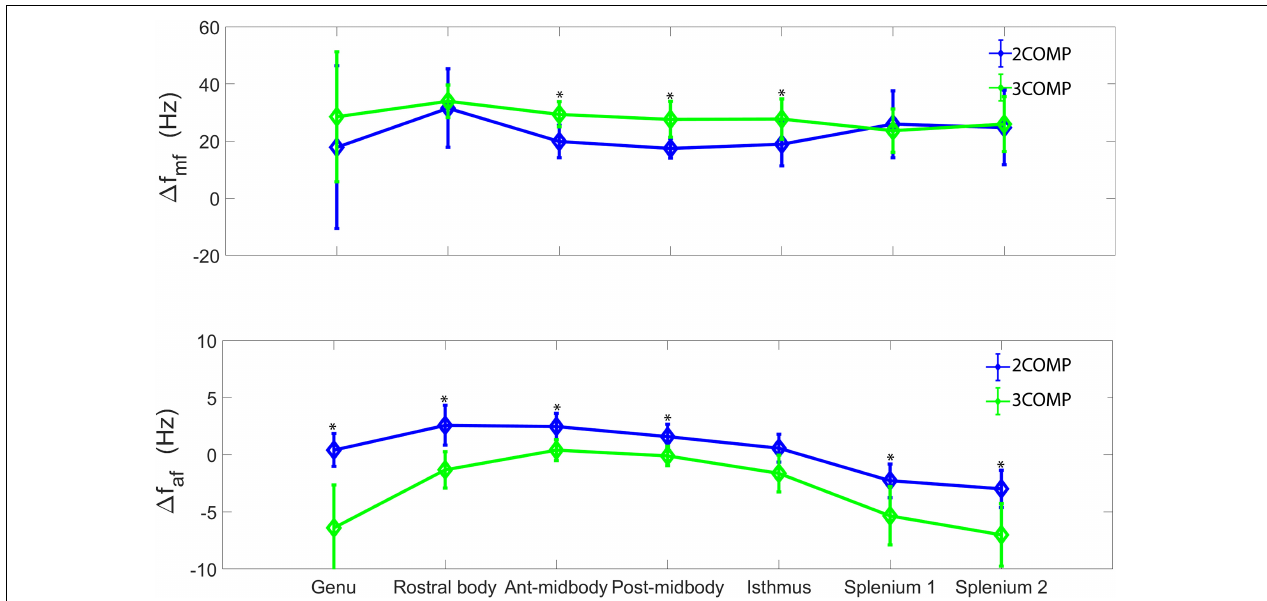
FIGURE 3 | Myelin ( (cid:49) f my ), and axonal ( (cid:49) f ax ) frequency shifts generated using 3COMP and 2COMP models over the seven corpus callosum regions. * represents the significant differences.